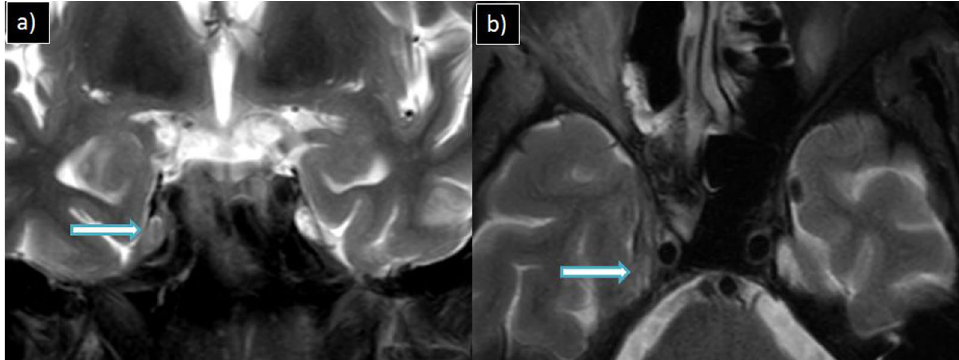
Fig. 4 a MRI coronal and b axial T2W-FS images of a 43-year-old male patient with complaints of rhinorrhea, ocular pain and blurring of vision showing altered signal intensity involving the right Meckel’s cave (arrow)